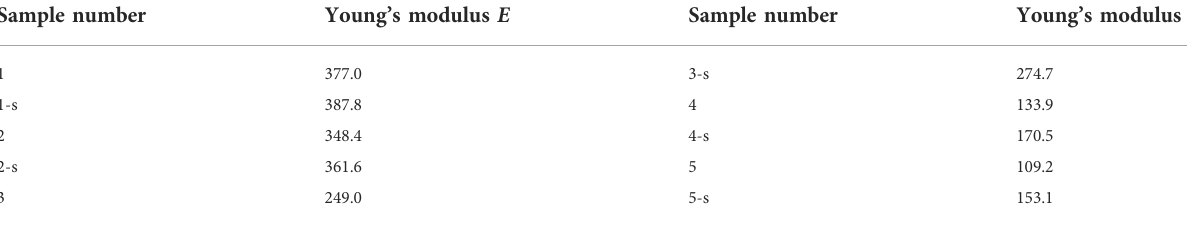
TABLE 4 Young ’ s modulus (values expressed in MPa) for the samples presented in Table